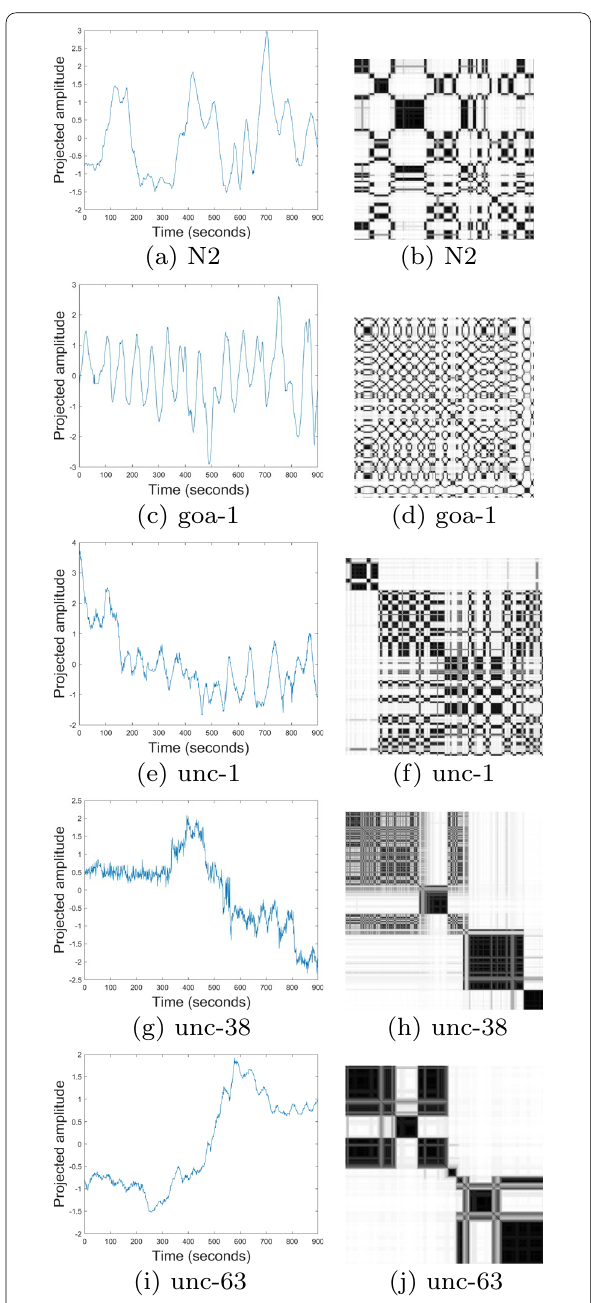
Fig. 2 Time series (left) and fuzzy recurrence plots (right) of wild type ( a , b ) and mutant ( c – j ) Caenorhabditis